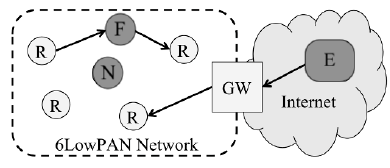
Figure 4. Network